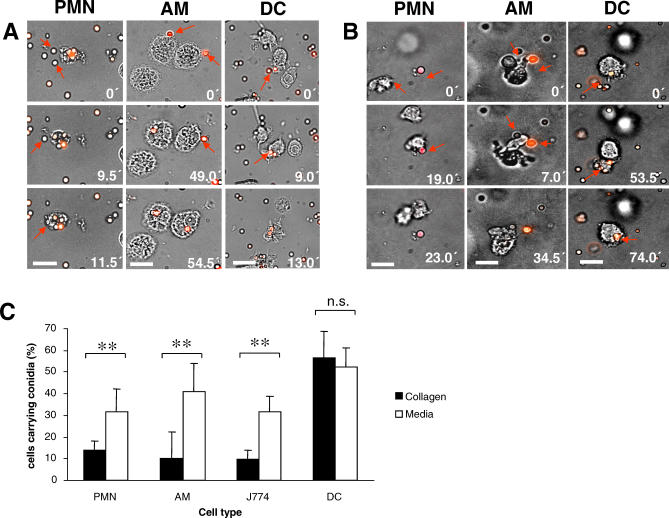
Phagocytosis of A. fumigatus Conidia by Different Phagocytes Is Dependent on the Dimensionality of the Environment(A) A pure fraction of immune cells and conidia was incorporated in a 2-D liquid-based system and subjected to time-lapse video microscopy. Panels show ingestion of conidia (marked by red arrows) by PMNs, AMs, and DCs. All cells were imaged over a period of 3 h.(B) Image sequences from PMNs, AMs, and DCs shown with A. fumigatus conidia in a 3-D collagen matrix. The left column time series displays the interaction of a red A. fumigatus conidium (indicated by red arrow) with a PMN and the latter's inability to ingest or drag the conidium despite contact. The middle column shows the unsuccessful interaction of an AM over a period of 2 h. The right column shows the efficient uptake of four conidia by a DC during a 3-h period. Bar = 25 μm.(C) A histogram quantitatively showing the influence of the environment (3-D, solid bar; 2-D, white bar) on the phagocytic ability of different cell types. The number of cells that had internalized conidia was counted 30 min after the start of imaging. The data represent the average of the percentage of cells internalizing conidia from three independent experiments, representing a total of 433 DCs in collagen, 356 DCs in media, 77 AMs in collagen, 229 AMs in media, 706 PMNs in collagen, 458 PMNs in media, 367 J774 cells in collagen, and 212 J774 cells in media. *, p < 0.05; **, p < 0.01; n.s., not significant. Error bars indicate SD.